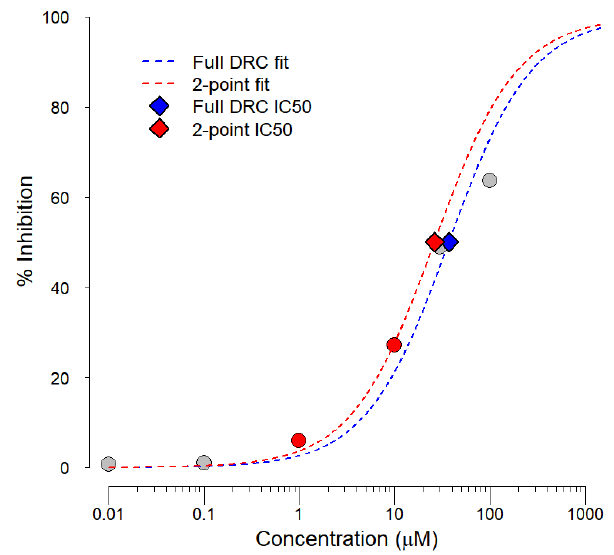
Figure 3. Sample plot for IC 50 derivation from six-point and two-point titration series.